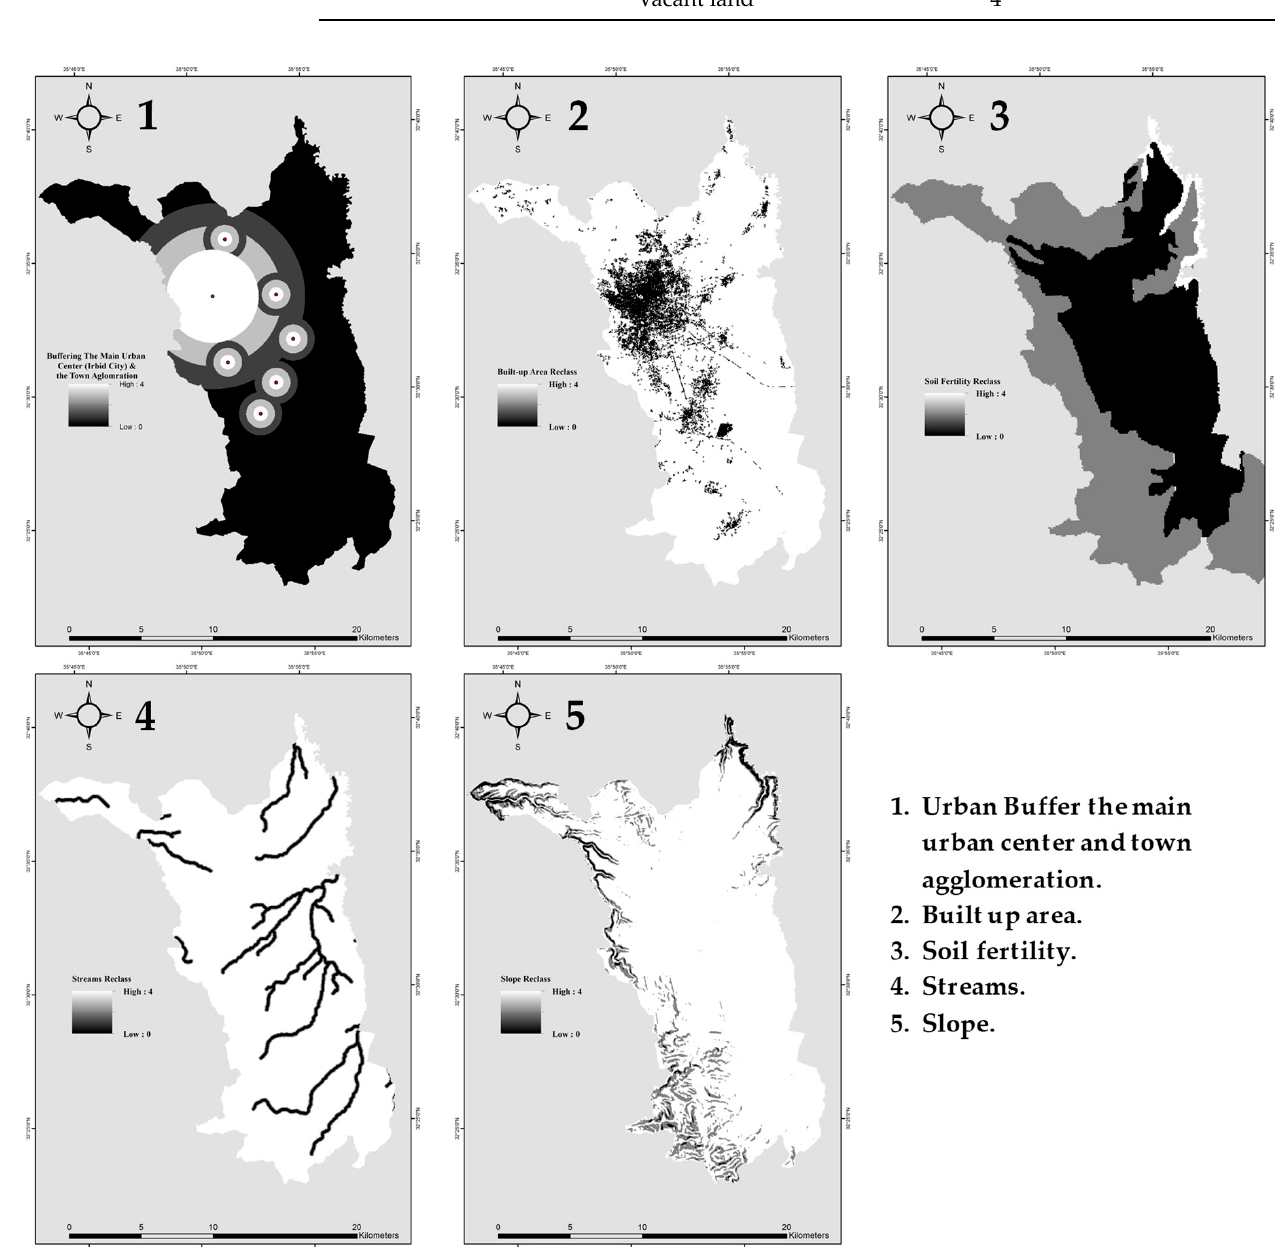
Figure 13. The factors after reclassified.